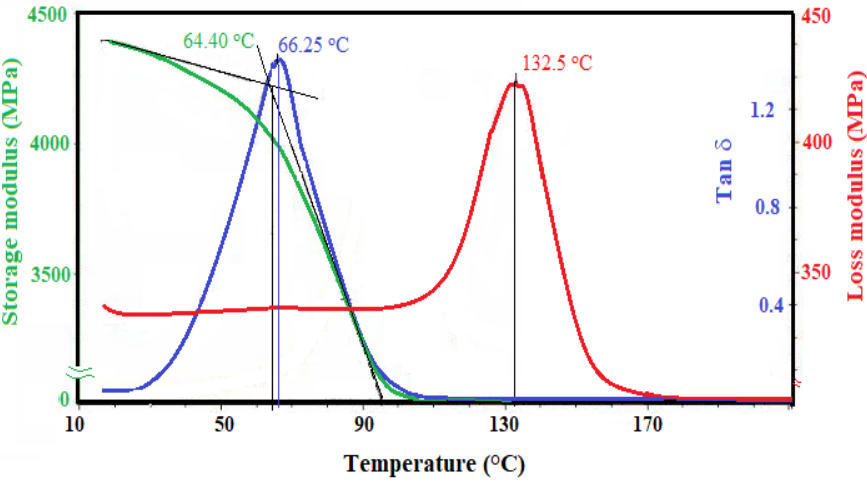
/ PAIIL (4:1) system.